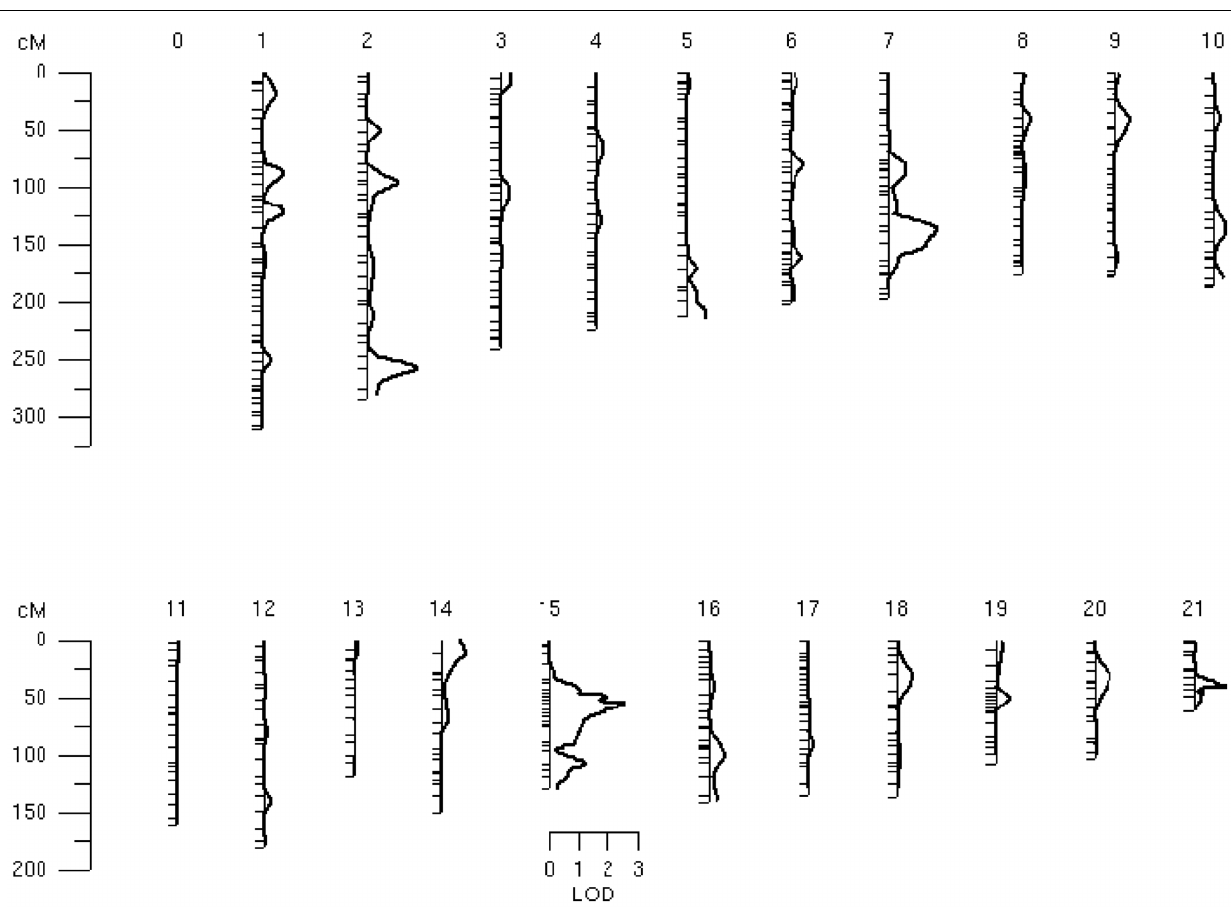
by averaging the values along the tracts for both hemispheres. The overall average FA values were calculated by averaging values for the entire WM